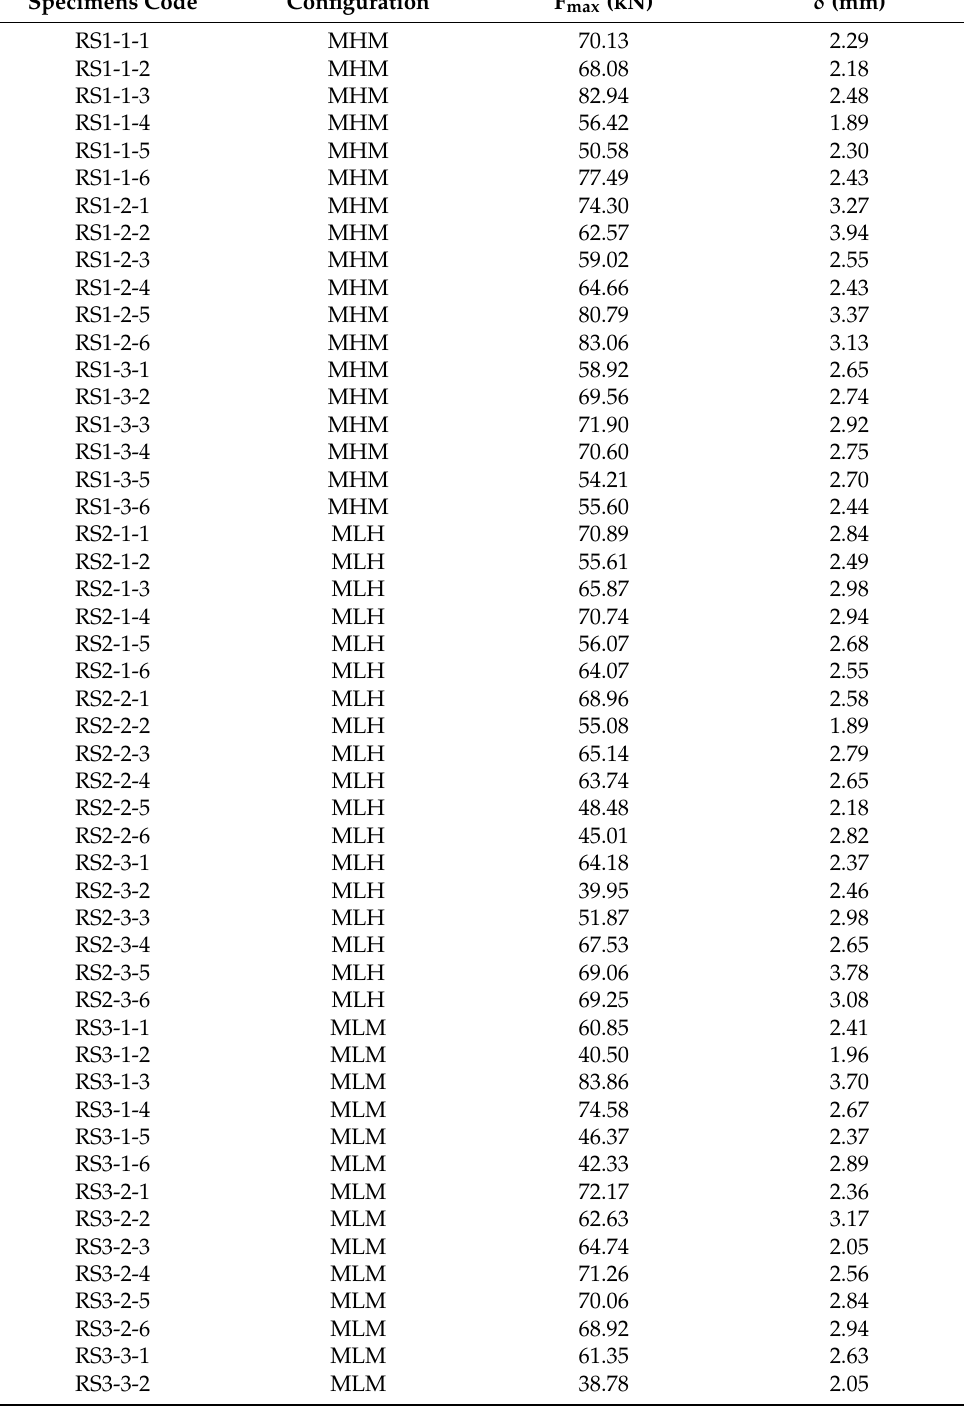
Table A1. Main results obtained from the planar shear